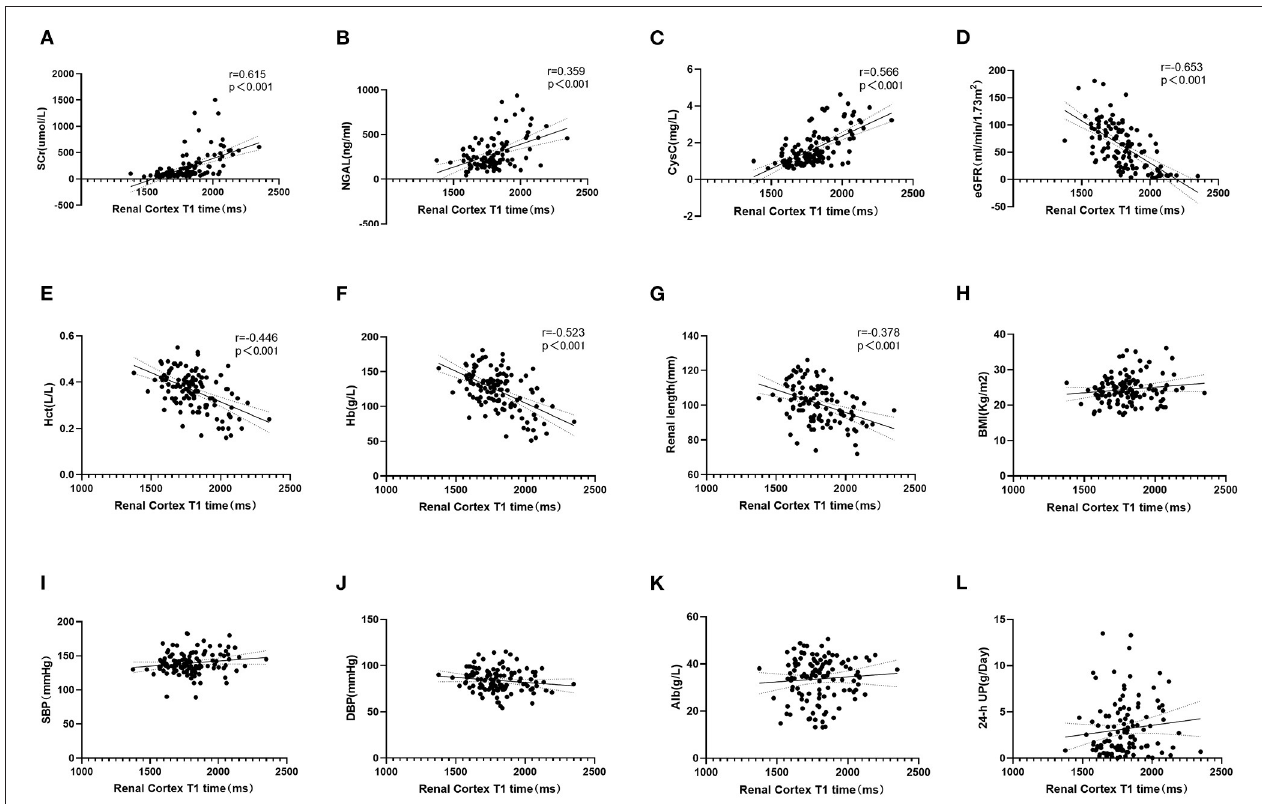
FIGURE 5 | (A–C) Correlation analysis between T1 and clinical indexes. T1 value was positively correlated with SCr, NGAL and CysC ( P < 0.001). (D–G) Negatively correlated with eGFR, Hct, Hb, and Renal length ( P < 0.001). (H–L) T1 value had no correlation with BMI, SBP, DBP, Alb, and 24-h UP ( p > 0.05).